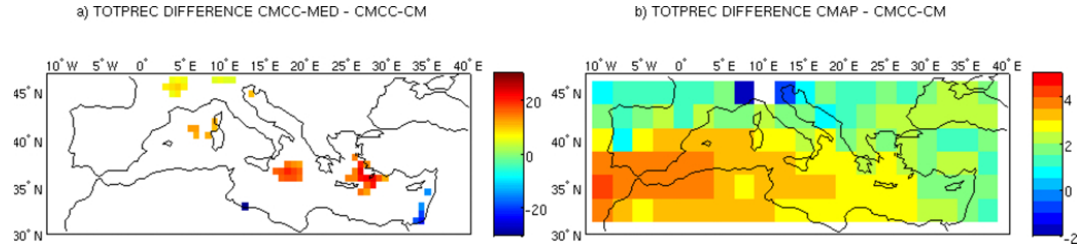
Fig. 6. Difference in mean total precipitation. Panel (a) : difference between the two models. Values are expressed in percentages (CMCC- MED-CMCC-CM)/CMCC-CM. Panel (b) : CMAP – CMCC-CM total precipitation (1981–2005). Values are absolute differences in mmdays − 1 . Isolines according to colorbars. Only statistically significant differences ( t test 95%) are